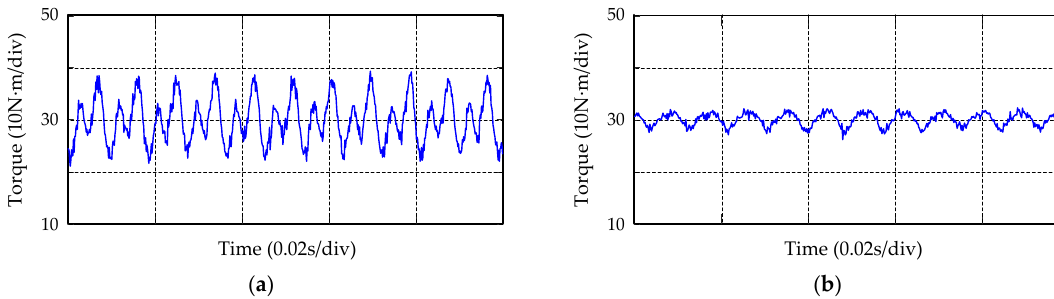
Figure 21. Torque waveform of five-phase PMSM: ( a ) Torque waveform of removing faulty phase after a short-circuit; ( b ) Torque waveform after adding RC.